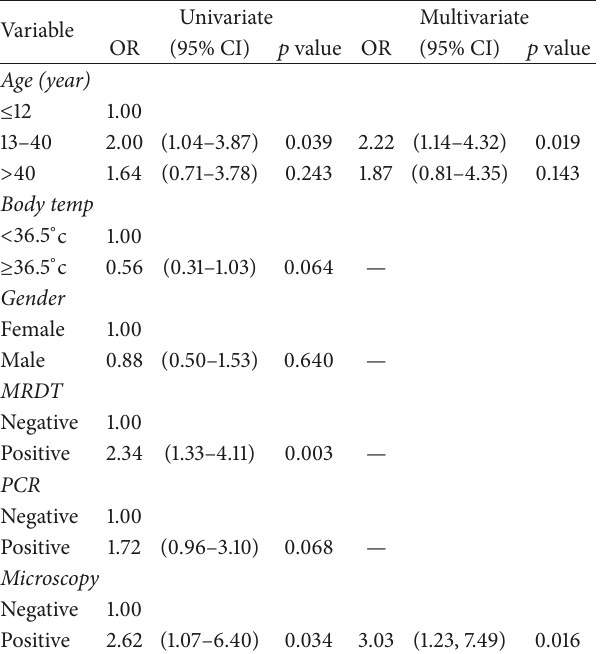
Table 3: Regression analysis of association between seropositivity and AS202.11 with other